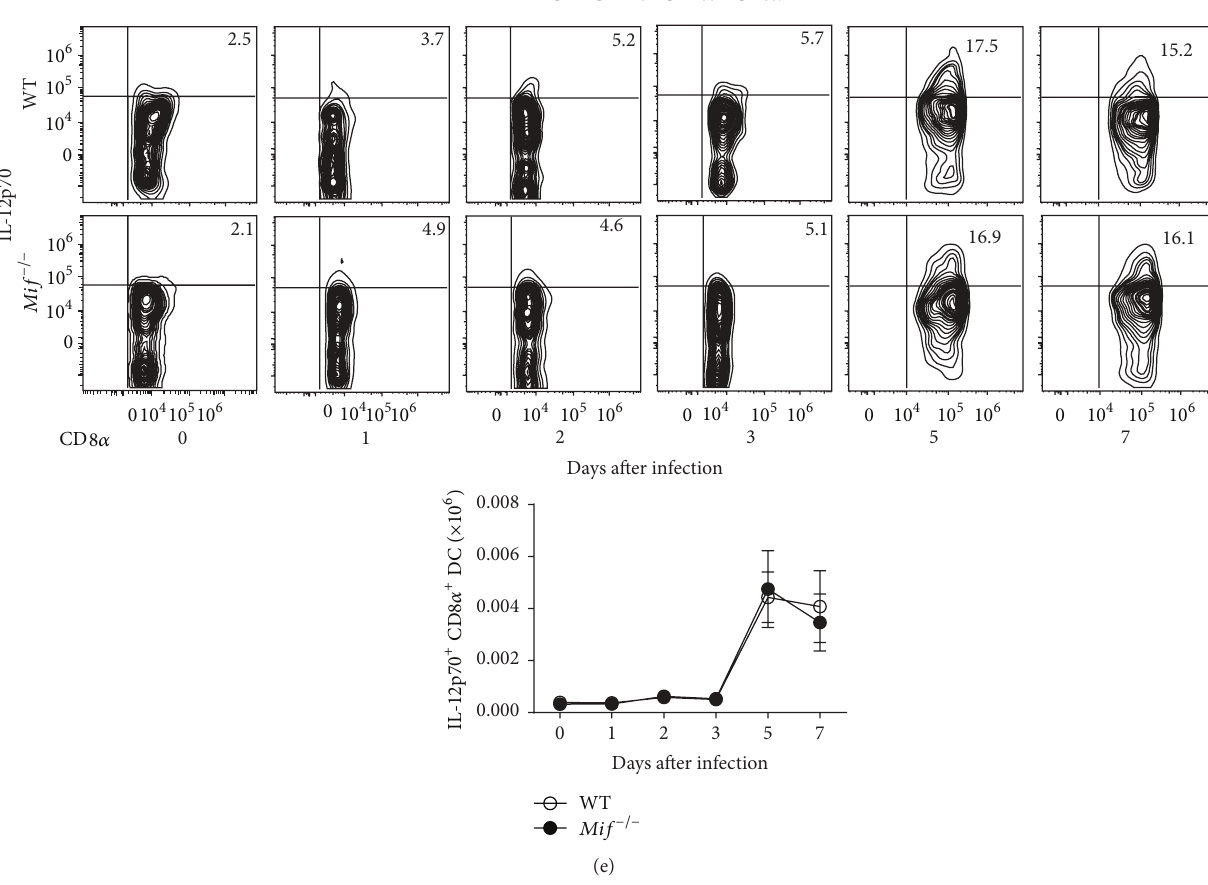
Figure 2: MIF induces IL-12 production on CD11b + but not CD8 𝛼 + DCs during the acute infection with T. gondii . WT ( I ) and Mif −/− ( e ) mice were i.p. infected with 100 cysts of T. gondii ME49 strain, sacrificed on days 0, 1, 2, 3, 5, and 7 after infection, and analyzed for intracellular IL-12p70 in CD11b + and CD8- 𝛼 + DCs by flow cytometry. (a) Gating strategy of MHCII + CD11c + CD11b + and MHCII + CD11c + CD205 + CD8 𝛼 + DCs. (b) Kinetics of the absolute numbers of CD11b + and (c) CD8 𝛼 + DCs. (d) Representative FACs (upper panel) and analysis of absolute numbers (lower panel) of IL-12p70 + CD11b + DCs. (e) Representative FACs (upper panel) and analysis of absolute numbers (lower panel) of IL-12p70 + CD8 𝛼 + DCs. Data are representative of 2 independent experiments ( 𝑛 = 3 animals at each time point) and are expressed as mean ± SE. ∗ 𝑃 < 0.05 ; ∗∗ 𝑃 < 0.01